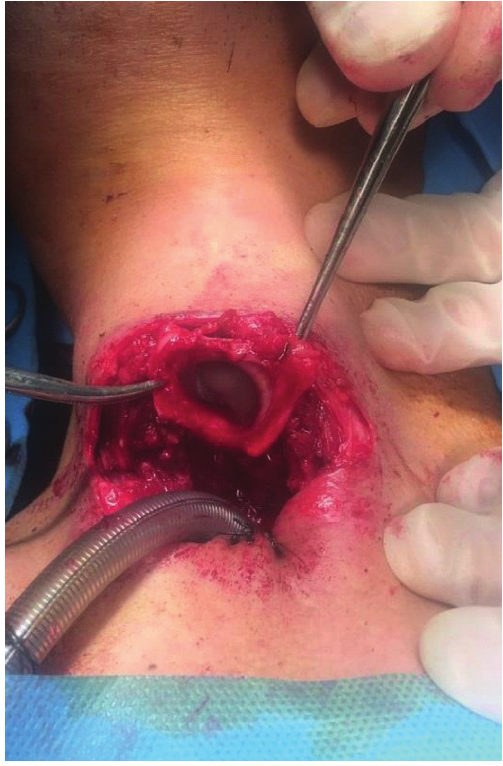
Figure 2: From the neck incision, the larynx is completely and circumferentially